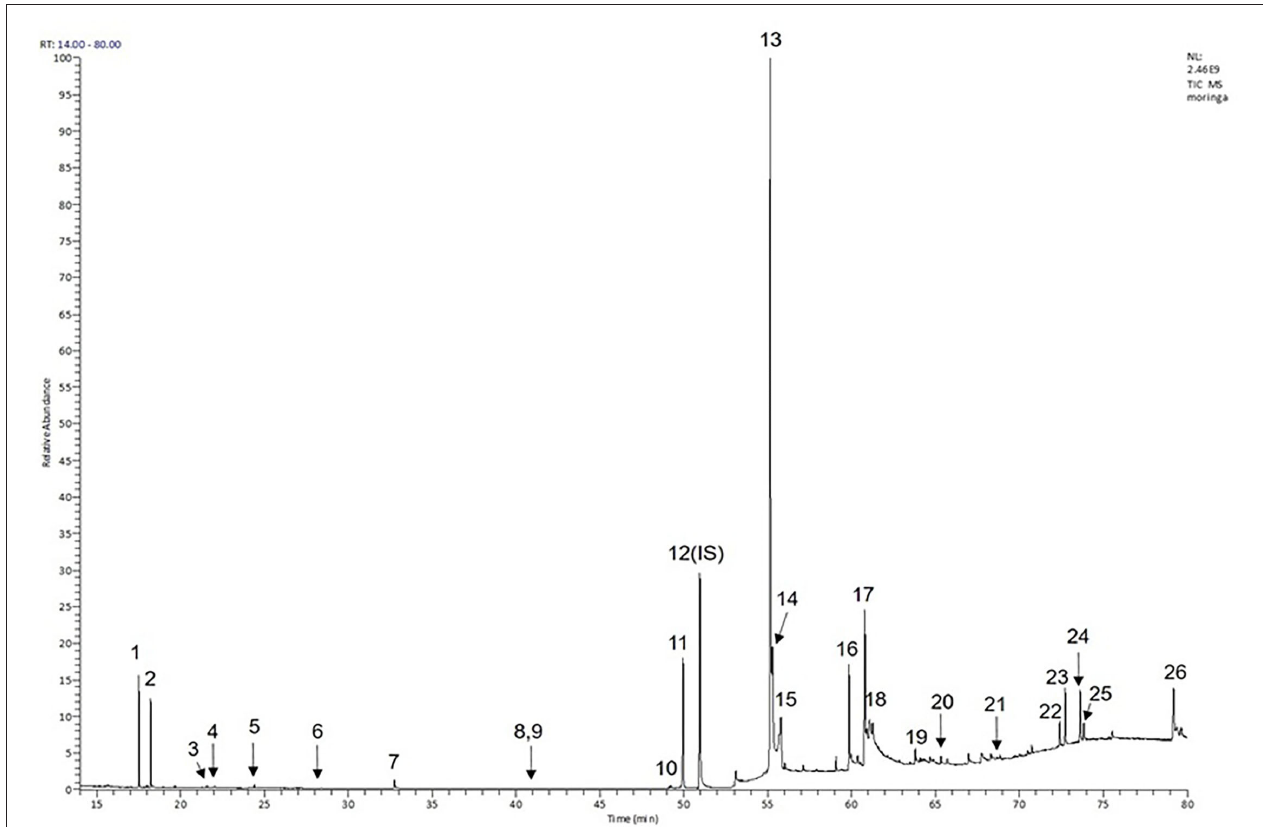
FIGURE 1 | Chromatogram obtained from the gas chromatography-mass spectrometry (GC-MS) with the Moringa oleifera seed oil (MOO).